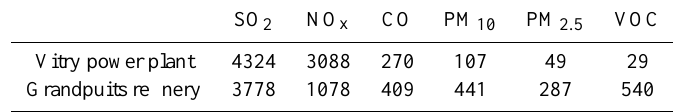
Table 1. Annual emission rates of gaseous and particulate species at the two industrial sources (tons year − 1 ). SO 2 NO x CO